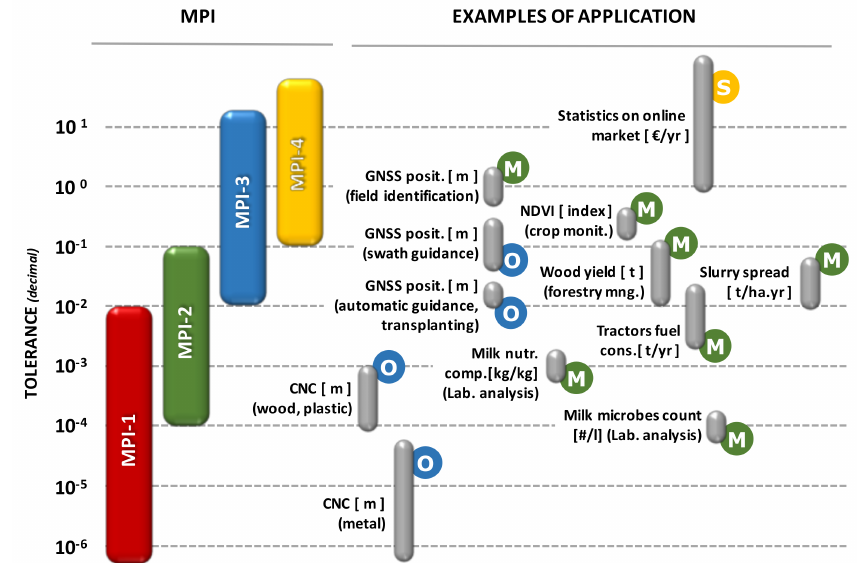
Figure 6. Typical ranges of tolerance in the four MPI (Macro-domains of Prevailing Interest, refer to Figure 3) and some examples of application. The usual hierarchic decisional level is also indicated (O: operative, M: management; S: strategic). Global Navigation Satellite System (GNSS); Computer Numerical Control